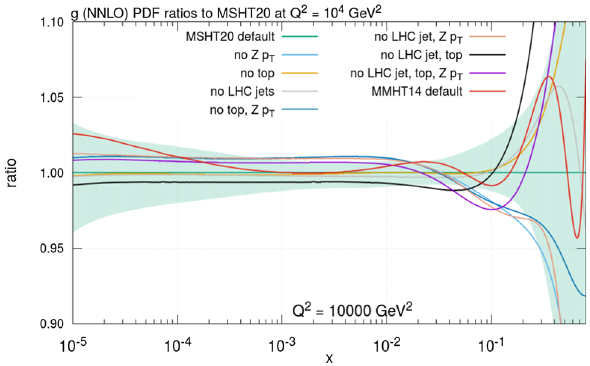
Fig. 18 The effects of removing the LHC jet, Z p T and top data sets on the high x gluon, shown in ratios to the default MSHT20